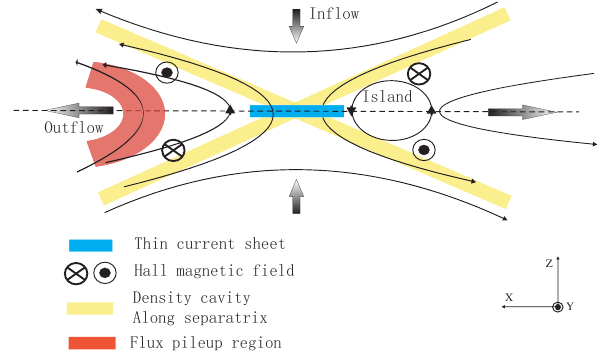
Figure 1. Schematic view of the 2-D reconnection geometry and the proposed structures for electron